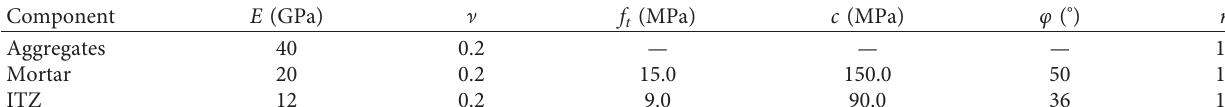
Figure 4: Loading schemes of the random-aggregate specimen: (a) uniaxial tension; (b) uniaxial compression. Table 1: Material parameters in the numerical testing.